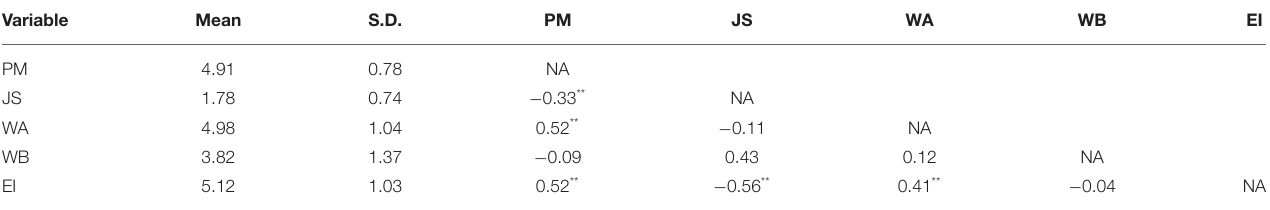
TABLE 3 | Descriptive statistics and correlations.